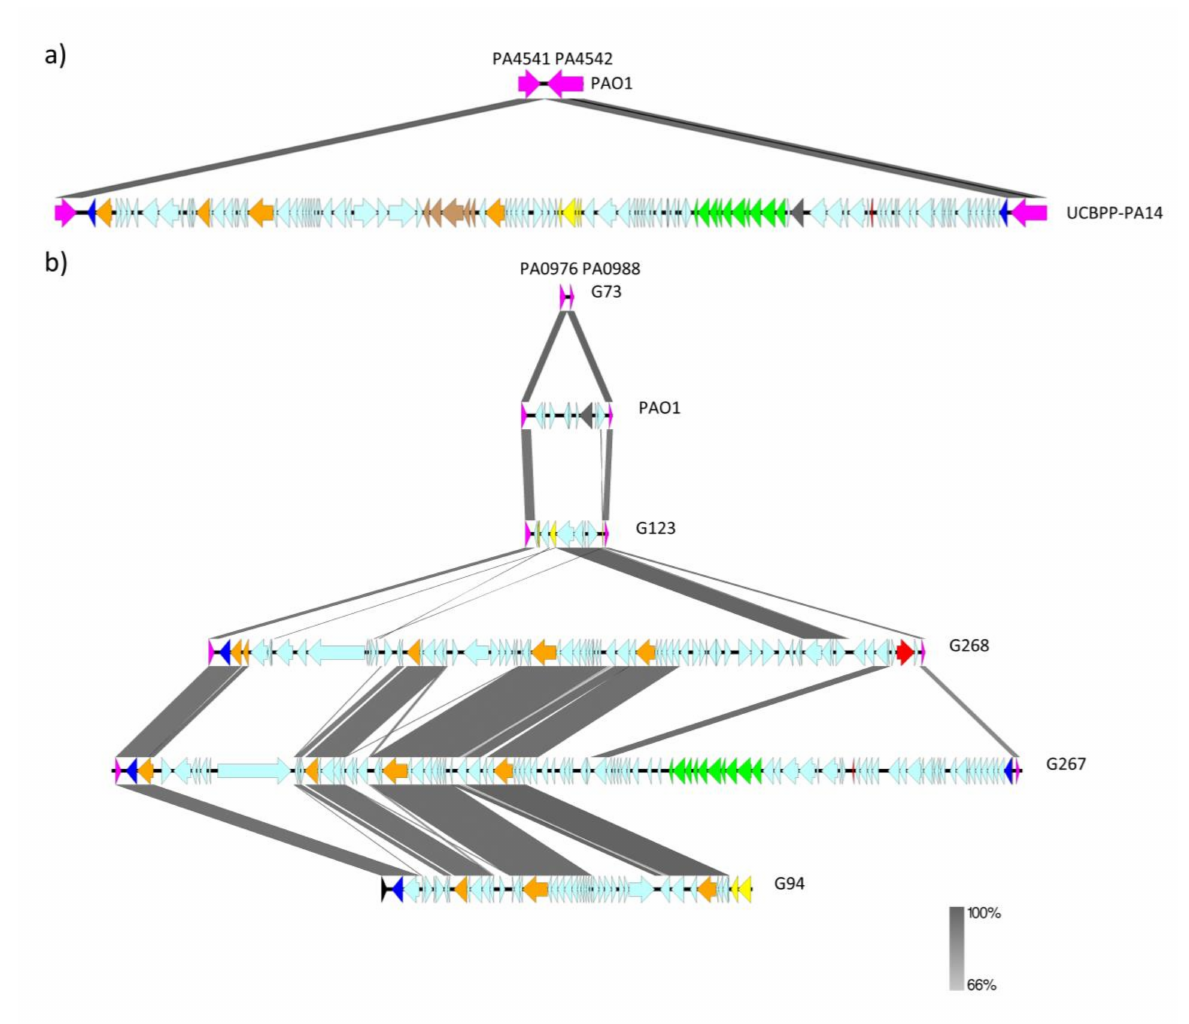
Figure 5. Mobile elements inserted after the tRNA-Lys of P. aeruginosa genome: ( a ) PA4541/PA4542 ( lepA/clpB ) empty region in PAO1 strain and crpP -ICE inserted in UCBPP-PA14 strain. ( b ) PA0976/PA0988 ( queC /CoAhydrolase) empty region in G73 strain, pyoS5 -ICE in PAO1 strain, PAGI-5-like in G123, exoU -PAGI in G268, crpP -ICE in G267, and an ICE removing from PA0988 to PA0998 in G94. Relevant genes are indicated by colored arrows as follows: xerD and parA genes (dark blue), mobilization genes ( virB, virD, tra genes and trb operon) (orange), pil operon (green), fimbrial operon (brown), mobile element ( IS and Tn) (yellow), pyocin gene (dark grey) and crpP and exoU genes